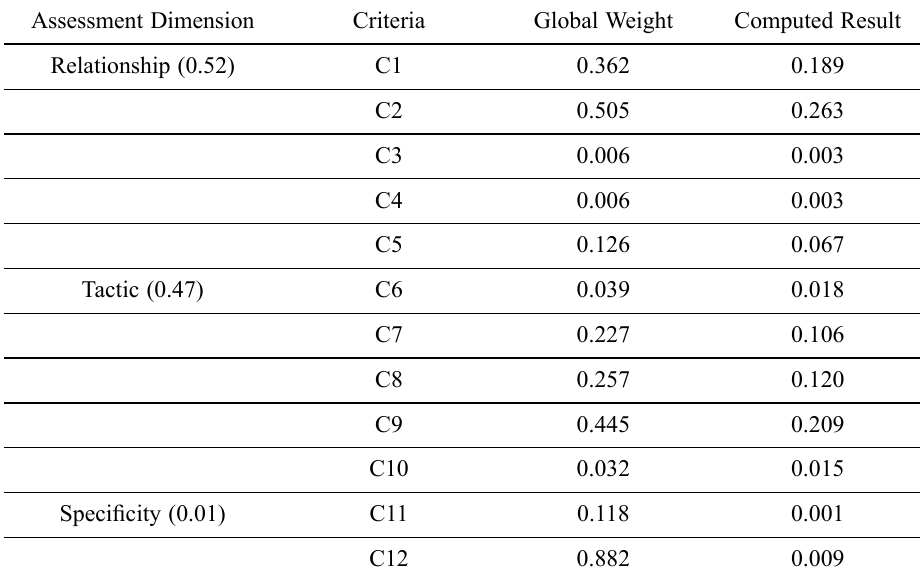
Table 9. The computed results for all